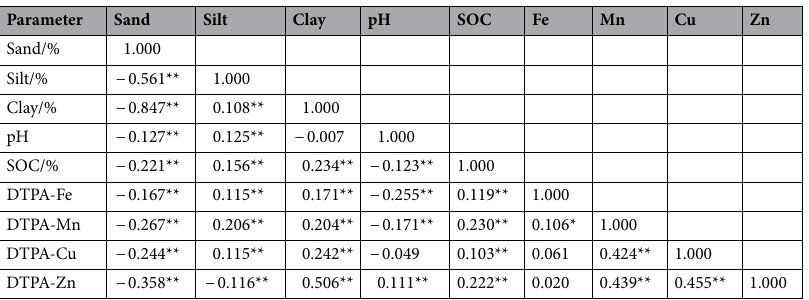
Table 4. Pearson’s correlation matrix between soil properties (particle size, pH, and SOC) and DTPA micronutrients (Fe, Mn, Cu and Zn/ mg kg −1 ) in the soils (0–15 cm) depth across NE India. *Significant at p < 0·05 level of significance (r = 0.0735); **Significant at p < 0·01 level of significance (r = 0.103).